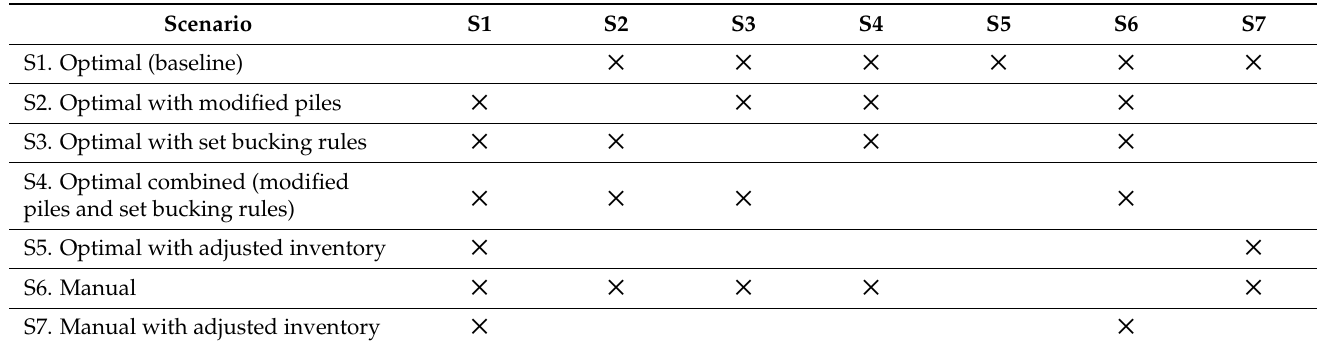
Table 2. Comparison matrix for the